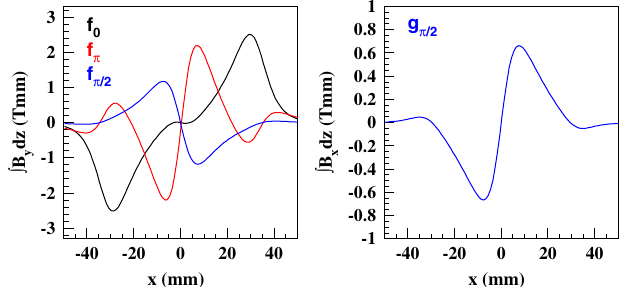
FIG. 4. Generic functions f 0 , f of the dynamic multipoles in the elliptic and inclined mode. The values are given for the BESSY II UE112 at smallest gap of 20 mm in the